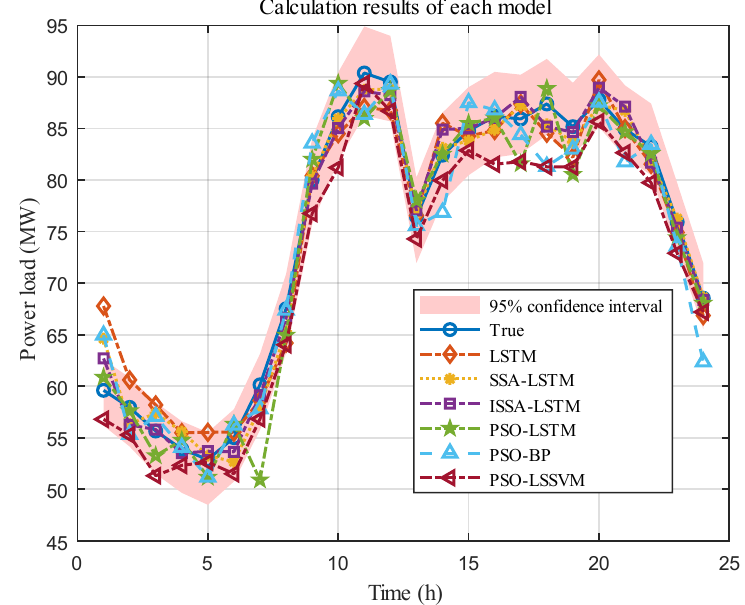
Figure 13. Comparison of prediction results by models.